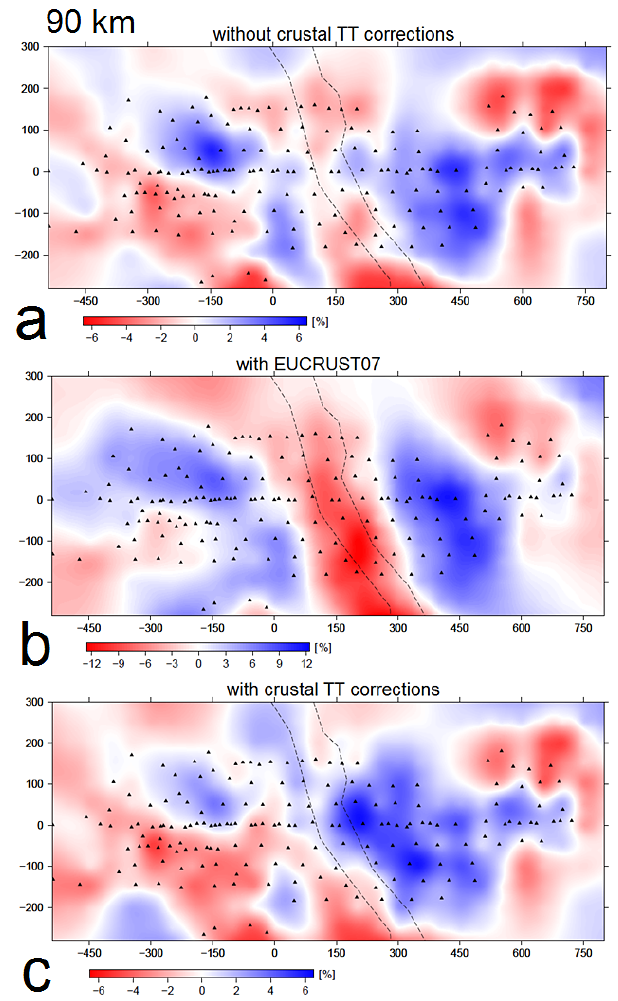
Figure 6. Horizontal slices at a depth of 90km of the inversion re- sults (a) without crustal TT corrections, (b) with the EuCRUST- 07 model, and (c) with crustal TT corrections compiled using the model by Majda´nski (2012) and the result of some DSS projects. Triangles indicate seismic stations. Dashed lines indicate the